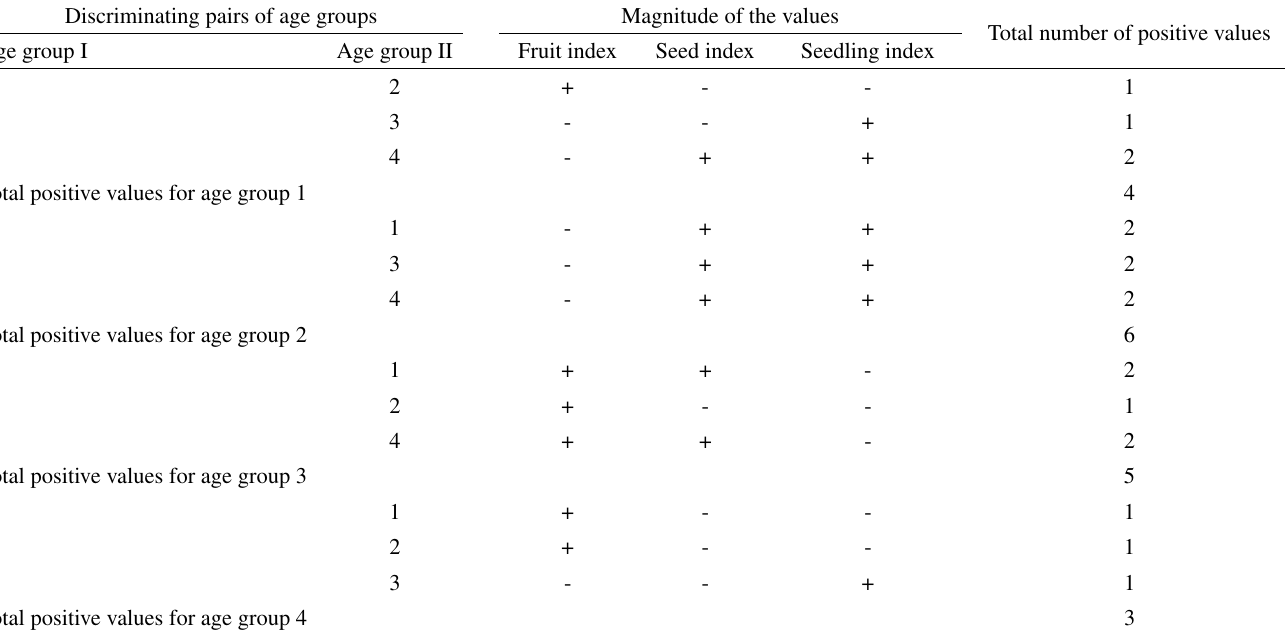
Table 7 - Direction of association of six discriminant function coefficients when used to compare each age group with the remaining three age groups in mangosteen ( Garcinia mangostana L.)